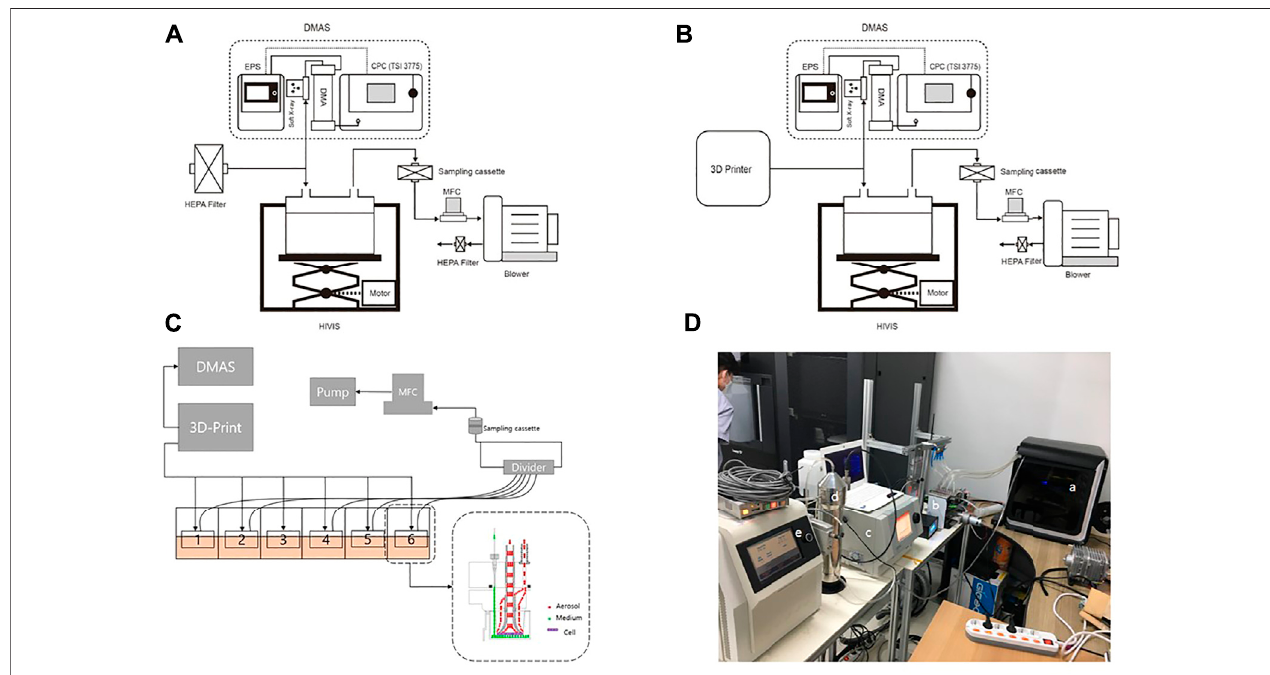
FIGURE 1 | HIVIS system for 3-D printer emission exposure. DMAS, differential mobility analyzing system; EPS, electrical particle sensor; HEPA fi lter, high- ef fi ciency particulate air fi lter; MFC, mass fl ow controller. (A) Control; (B) 3-D printer emission exposure; (C) scheme of 3-D printer emission exposure to 6-transwell plate; (D) experimental setup. (a) 3-D printer; (b) HIVIS; (c) CPC; (d) DMA; (e) EPS.